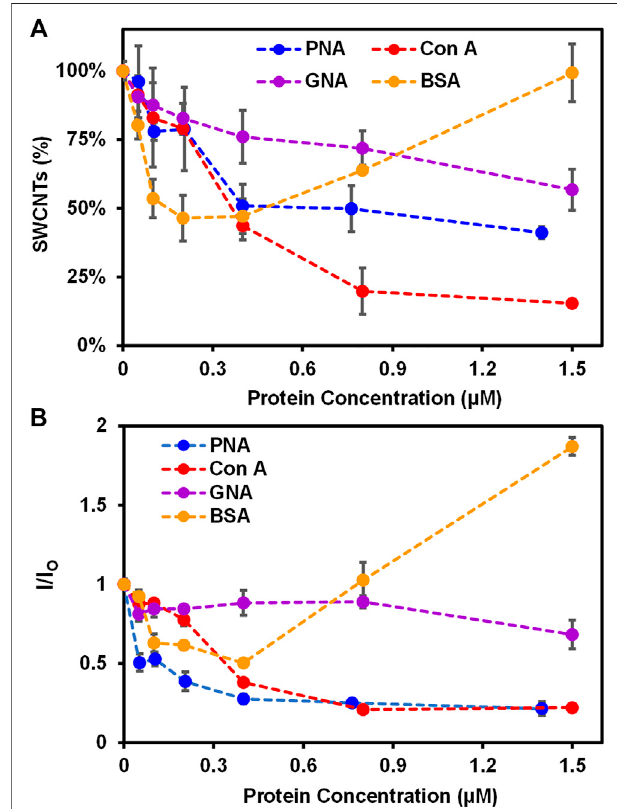
FIGURE 2 | Interactions of Glyco-SWCNTs with proteins. (A) Percentage of SWCNTs remaining in the supernatant determined from the sample absorption at 780 nm and the corresponding changes in (B) the NIR emission intensity ratio at the maximum E 11 peak wavelength (i.e., 1013 nm) of Glyco-SWCNTs after incubating nanotubes with different proteins including PNA, Con A, GNA, and BSA, respectively, for 5 min. The nanotube concentration of Glyco-SWCNTs is kept constant at 4.21 ± 0.13 μ g/ml, while the protein concentration ranges from 0 to 1.50 ± 0.20 µM. A fi xed excitation wavelength of 532 nm laser was used for NIR fl uorescence spectra